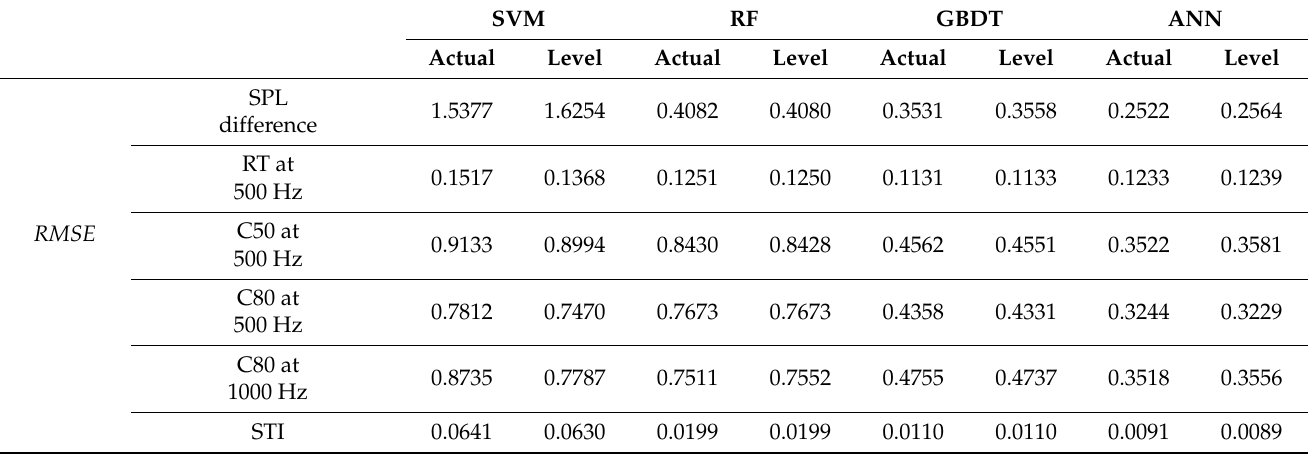
Figure 19. The RMSE of RT by data processing for absorption coefficient.